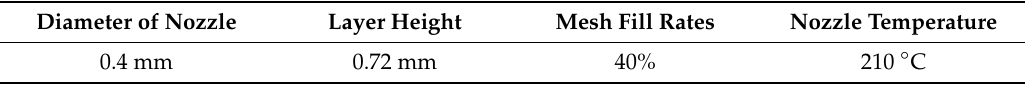
Table 1. 3D printing parameter.